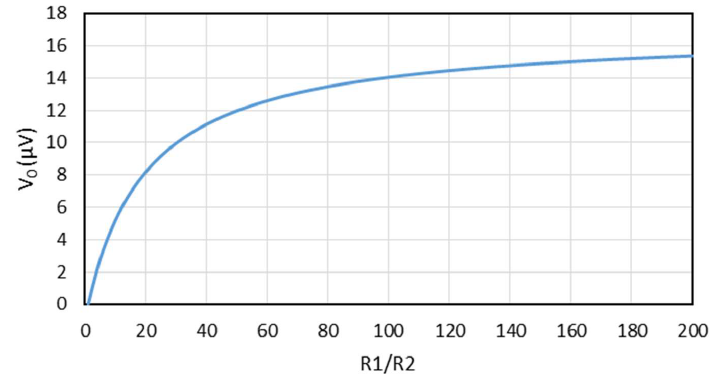
Figure 6. The generated voltage V 0 versus R 1 / R 2 plotted from Equation (21) with a temperature difference of 1 K.